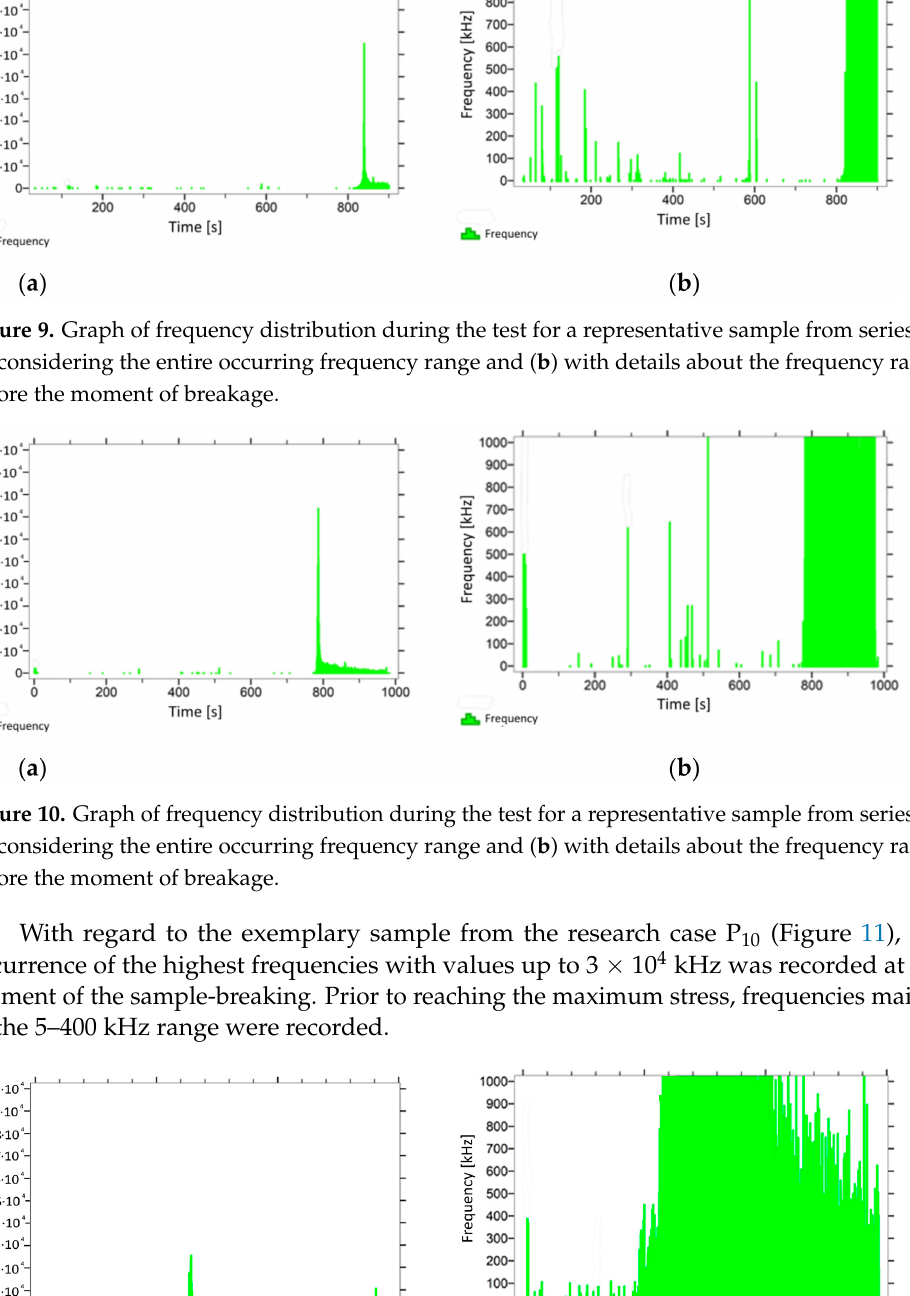
( b ) Figure 12. Graph of frequency distribution during the test for a representative sample from series P 11 : ( a ) considering the entire occurring frequency range and ( b ) with details about the frequency range before the moment of breakage. ( a ) ( b ) Figure 13. Graph of frequency distribution during the test for a representative sample from series P 12 : ( a ) considering the entire occurring frequency range and ( b ) with details about the frequency range before the moment of breakage.